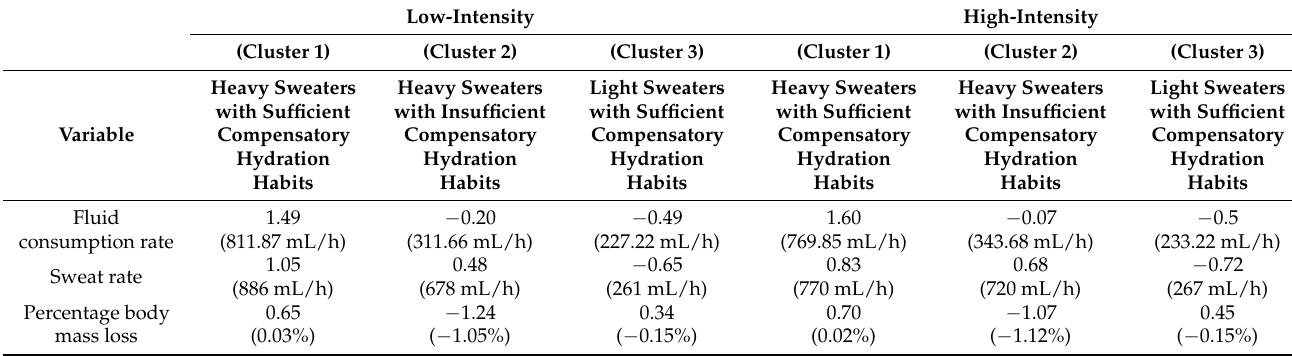
Table 4. Final cluster centres (standardized Z values) and mean values (in brackets) of fluid balance and fluid consumption